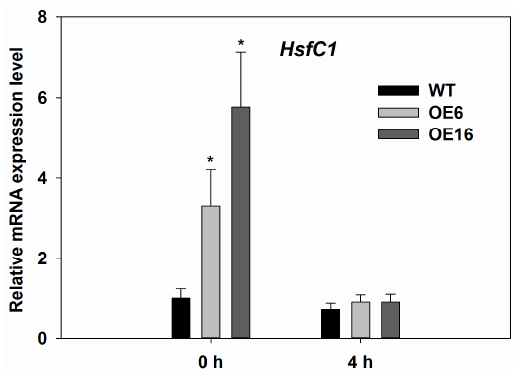
Figure 8. Relative mRNA expression level of endogenous HsfC1 in WT and transgenic lines. Leaves of WT, OE6, and OE16 were collected under normal temperature and heat stress (37 °C) conditions for 4 h. Values were means ± SD of three different biological replications (with two technical replications for each biological replication). Asterisks on the top of bars indicated significant differences between WT and transgenic lines at each time period according to Fisher’s protected LSD test ( p < 0.05).